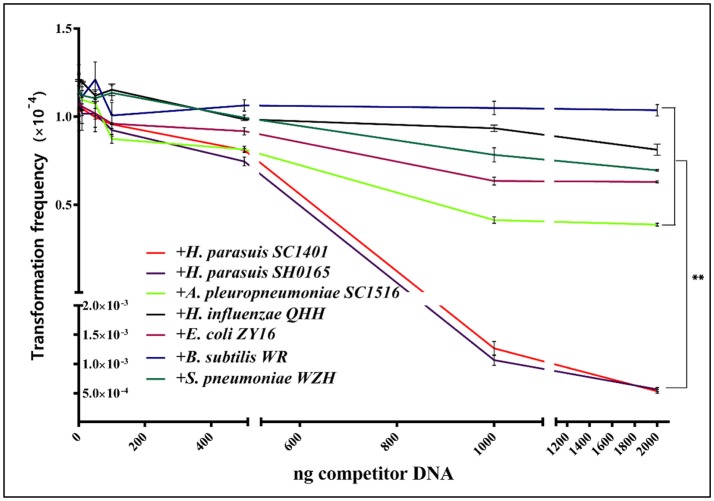
H. parasuis transformation could be inhibited with unmarked homologous DNA. H. parasuis transformation could be inhibited by exogenous DNA and moderately inhibited by DNA from closely-related A. pleuropneumoniae. Increasing amounts (0, 10, 50, 100, 500, 1,000, and 2,000 ng) of competitive DNA from either homologous and heterologous strains were added to the mixture with constant amount (1 μg) of SC1401ΔhtrA::kan chromosomal DNA. Transformation frequency shows the number of KanR transformants per cfu of recipient cells. Data are representative of three independent experiments. Solid lines with different colors indicate source of competitor DNA.